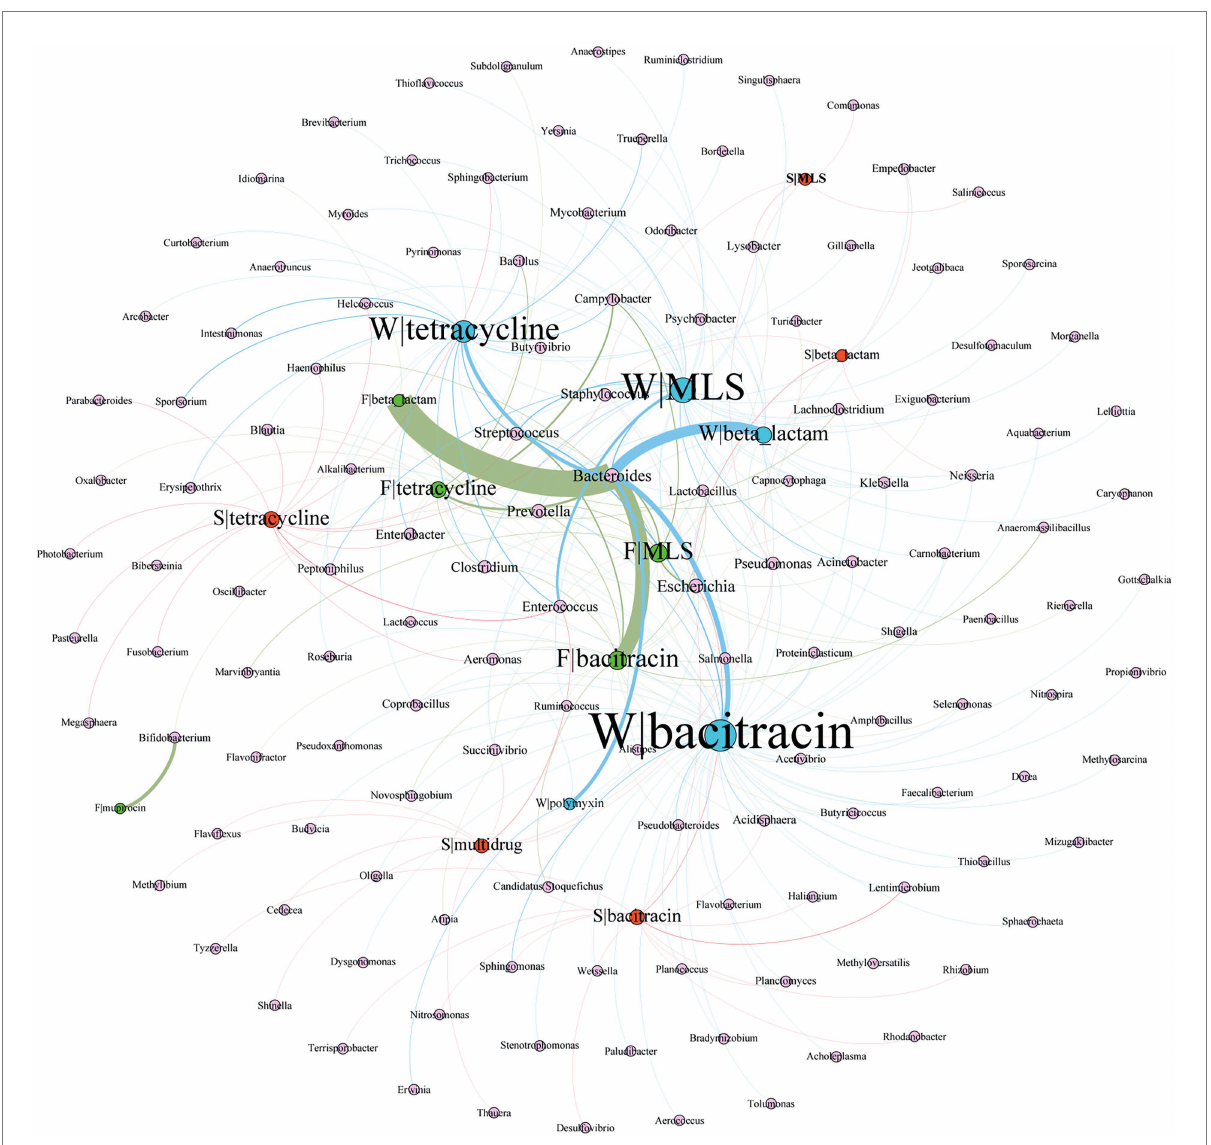
FIGURE 5 Network analysis of co-occurrence patterns between five major ARG types and major ARG hosts. The nodes were colored according to sample type (blue, wastewater; green, feces; orange, soil). The size of each node was proportional to the number of connections, i.e., the average weighted degree. W, wastewater; F, feces; S, soil. For example, F|tetracycline represents the resistance gene of tetracycline from